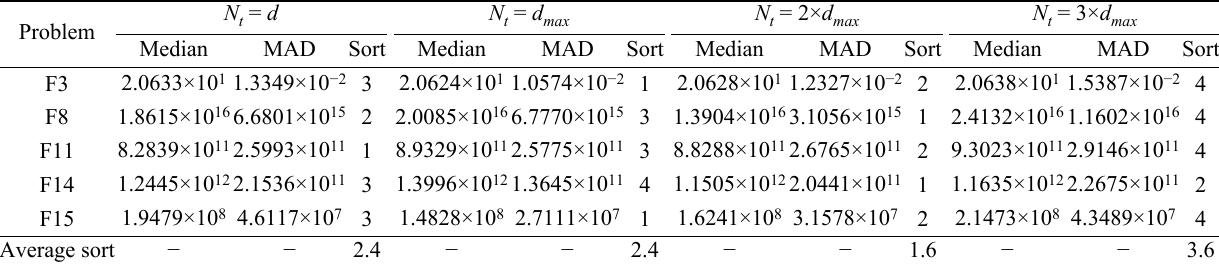
Table 2 Statistical results of the optimal objective values, given in median and median absolute deviation (MAD), on F3, F8, F11, F14, and F15 problems obtained by different sizes of the test set. Problem